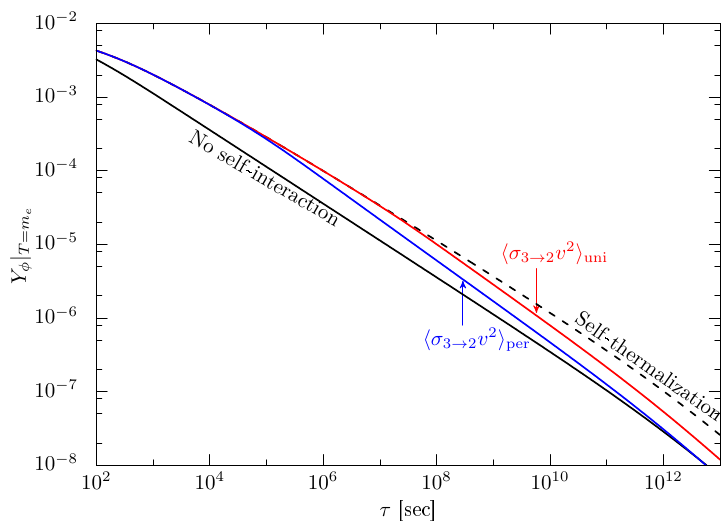
Figure 15. The upper limits on the dark scalar abundance from the N eff constraint for different choices of the self-scattering cross sections, h σ 3 → 2 v 2 i . Here, we take m φ = 2 MeV . This figure provides the closeup of the N eff constraint in figure